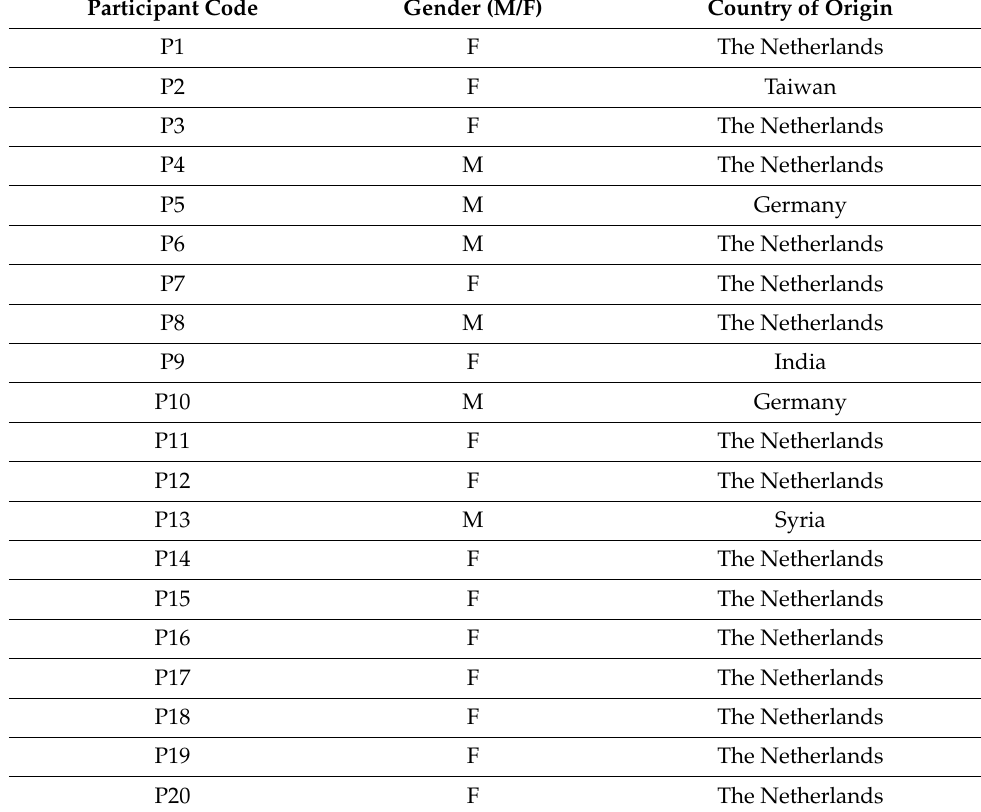
Table 2. Participant